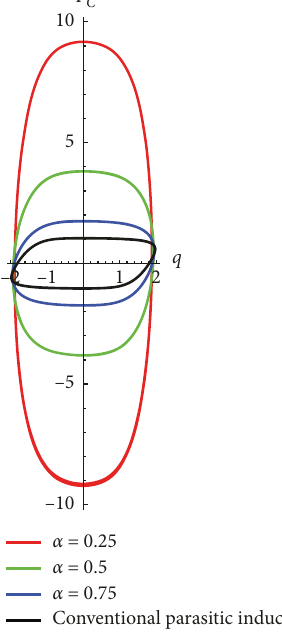
Figure 20: Φ C vs q the memristor-capacitor circuit with the nonlinear parasitic fractional inductor/nonlinear conventional parasitic